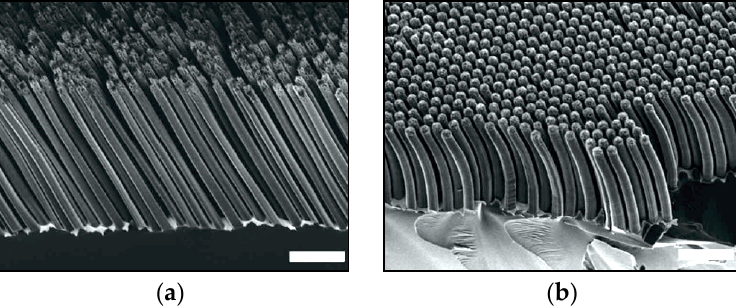
Figure 7. SEM images of Si nanowires etched for 20 min in HF–H 2 O 2 –water–co-solvent ( a ) isopropanol 2:1:5:2 and ( b ) acetonitrile 2:1:5:2. All scale bars are 2 µ m. The figure was adapted with permission 2:1:5:2 and ( b ) acetonitrile 2:1:5:2. All scale bars are 2 µm. The figure was adapted with permission from Y. Kim et al., 2013. from Y. Kim et al, 2013. [74].